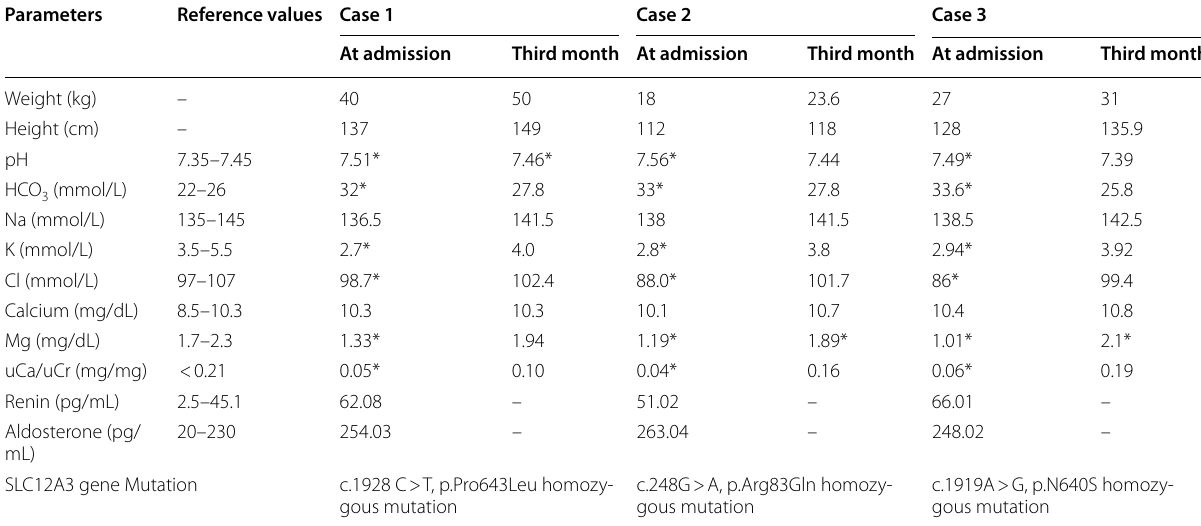
Na, Sodium; K, Potassium; Cl, Chloride; Mg, Magnesium; uCa, urine calcium; uCr, urine